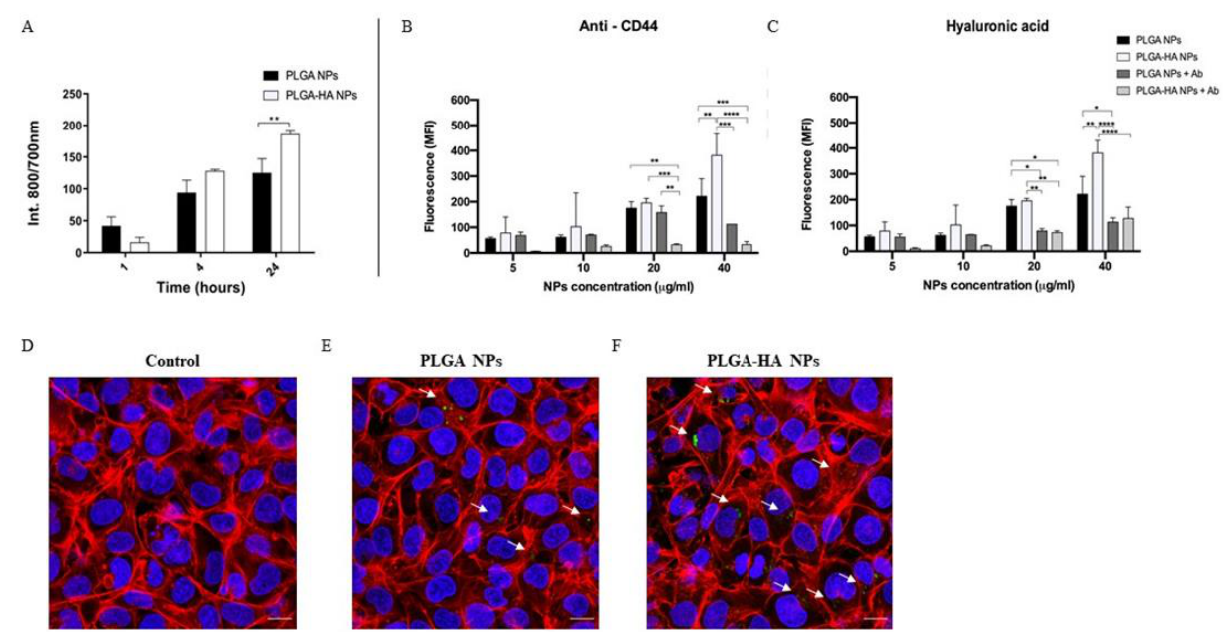
Figure 6. Measurement and visualization of C28/I2 cellular uptake of NPs. ( A ) In vitro cellular uptake of PLGA NPs and PLGA-HA NPs. The C28/I2 cells were incubated at 1, 4, and 24 h with a NP concentration of 40 µ g/mL ( n = 3). ( B , C ) In vitro cellular uptake of PLGA NPs and PLGA-HA NPs characterized by FACS. The C28/I2 cells were incubated for 24 h with NP concentrations of 5, 10, 20, and 40 μ g/mL. ( B ) The cells were previously treated with anti-CD44 antibody and ( C ) with hyaluronic acid. ( D – F ) Confocal microscopy images. ( D ) Control, consisting of cells without NPs, € PLGA NPs and ( F ) PLGA-HA NPs. Phalloidin-TRITC (red), cell nucleus with DAPI (blue), and FITC NPs (green arrows). The images were made with Leica SP8 confocal microscopy at 60 × magnification. White bar indicates scale bar at 10 µm. ** Indicates statistically significant difference (p < 0.05) and *** statistically significant difference (p < 0.001).